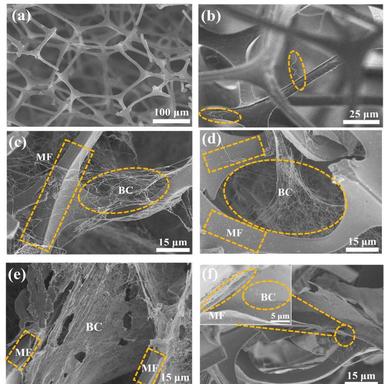
Representative SEM images from the transversal views for (a) MF; (b) BC16-MF; (c) BC32-MF; (d) BC48-MF; (e) BC64-MF; (f) BC96-MF.